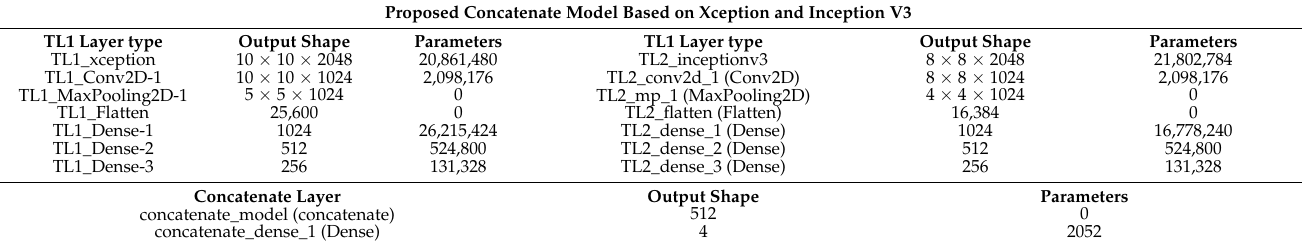
Figure 4. The proposed architecture of concatenation model based on the modified Xception and Inception V3 models. Table 12. The detailed architecture of the proposed concatenation model based on the modified Xception and Inception V3 models.